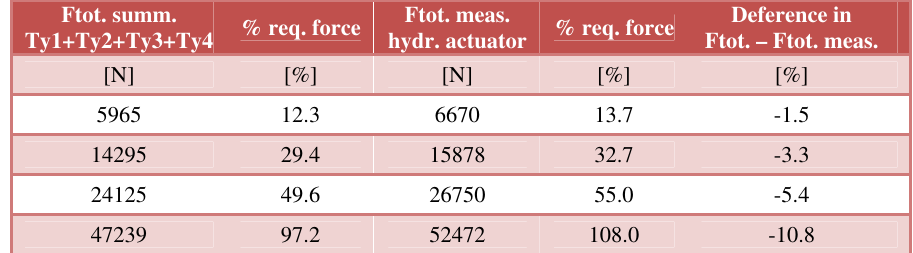
Table 4. Total forces during the test – combination case Ftot. summ.